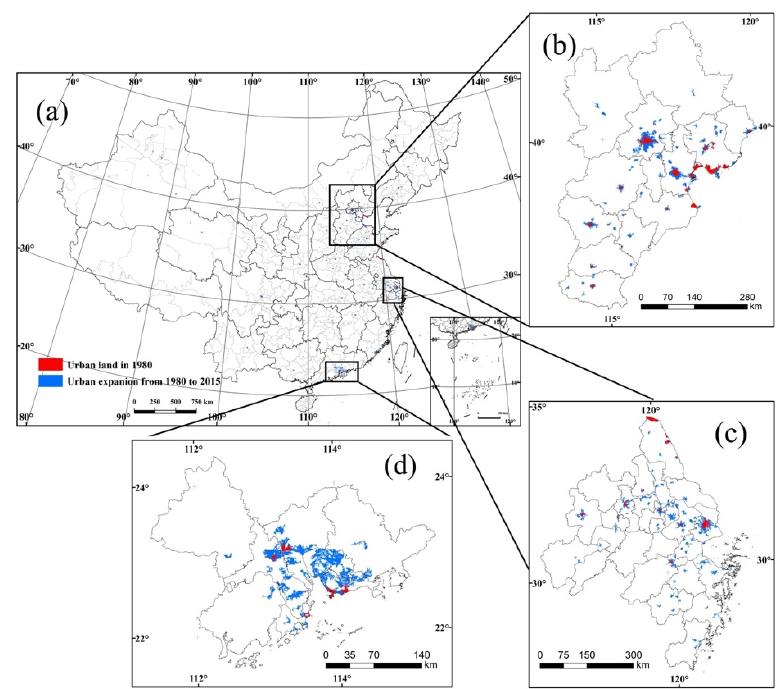
Figure 2. Urban lands in the 1980s and urban expansion from the 1980s to 2015 in ( a ) China, ( b ) the Beijing–Tianjin–Hebei urban agglomeration (BTHUA), ( c ) the Yangtze River Delta urban agglomeration (YRDUA), and ( d ) the Pearl River Delta urban agglomeration (PRDUA).